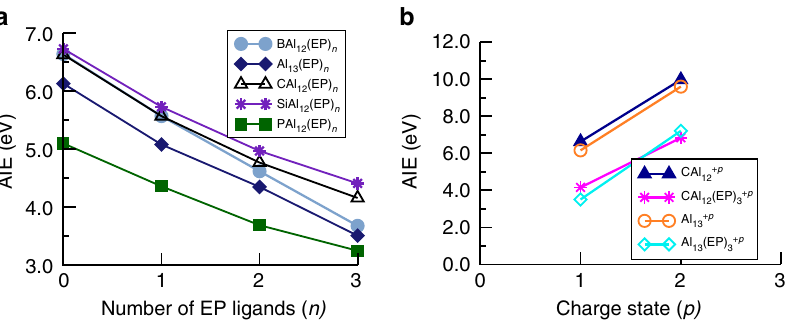
−18−16−14−12−10−8−6−4−20 Fig. 6 One-electron energy levels of CAl 12 (EP) n ( n = 0 – 3) clusters. The occupied and unoccupied states are represented by solid and dashed lines. Fig. 7 Fragment analysis of CAl